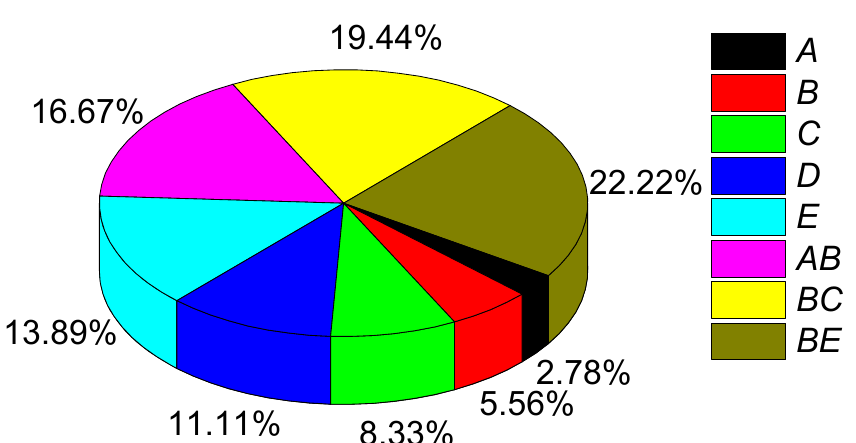
Figure 4. Significance analysis of the effects of the studied variable and their interactions on the corrosion resistance of the coating.